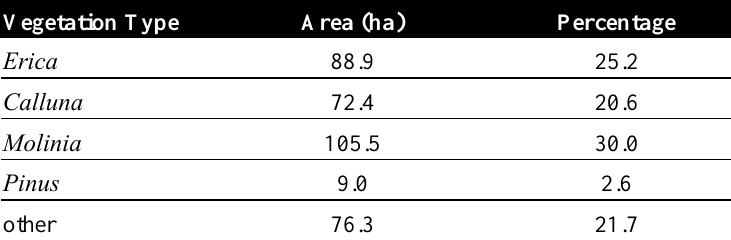
Table 3. Area and percentage of each vegetation type within the burn scar. Areas not belonging to one of the four vegetation types are grouped in